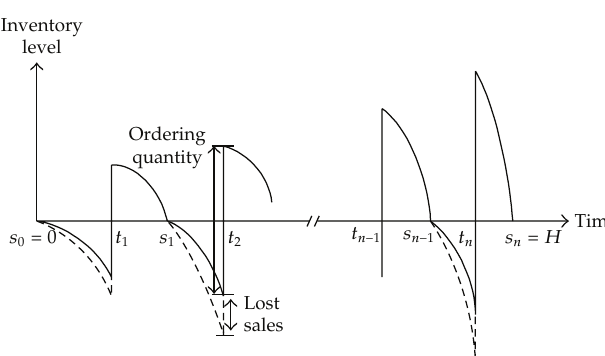
Figure 1: Graphical representation of inventory